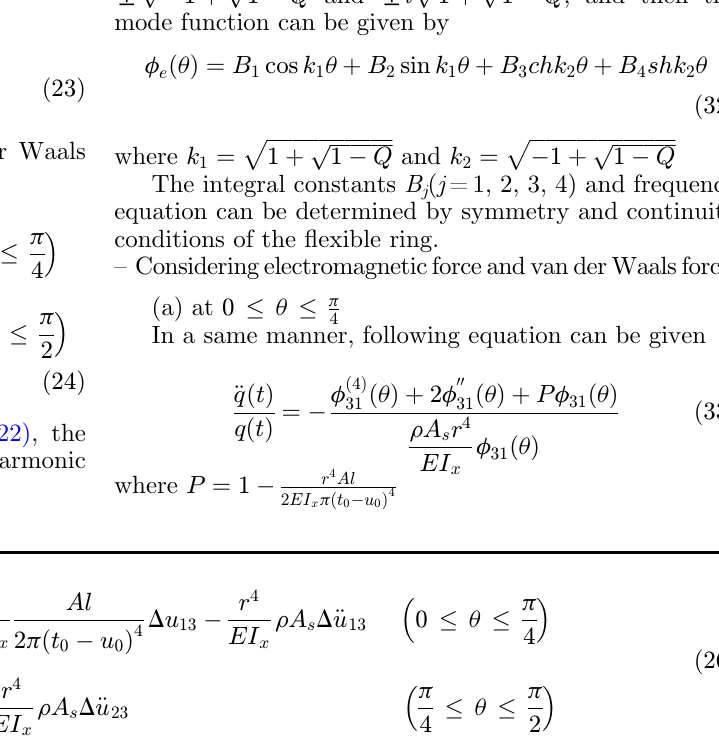
ffiffiffiffiffiffiffiffiffiffiffiffiffi p p 1 (cid:1) Q